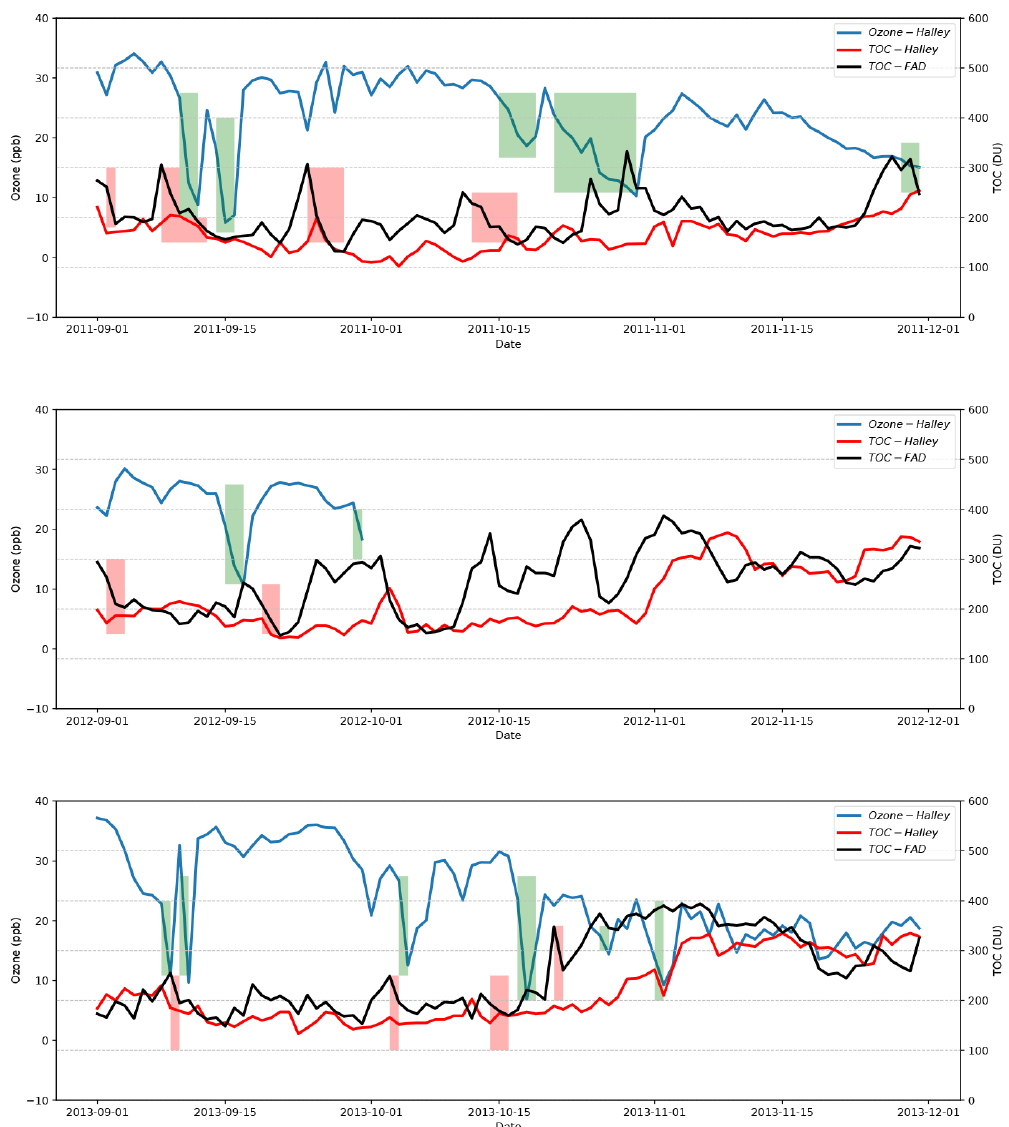
Figure 1. Time series of TOCs belonging to the Halley station and the Faraday-Vernadsky (FAD) station as well as the surface ozone detected at the Halley station during the springtime of years 2007–2013 (the observational data of the surface ozone for October and November in the year 2012 are missing). The green-shaded areas in the figure indicate the periods identified as the occurrence of ODEs at Halley in the present study, and the red-shaded areas represent the significant decline in TOC at FAD, which might be associated with the occurrence of ODEs at